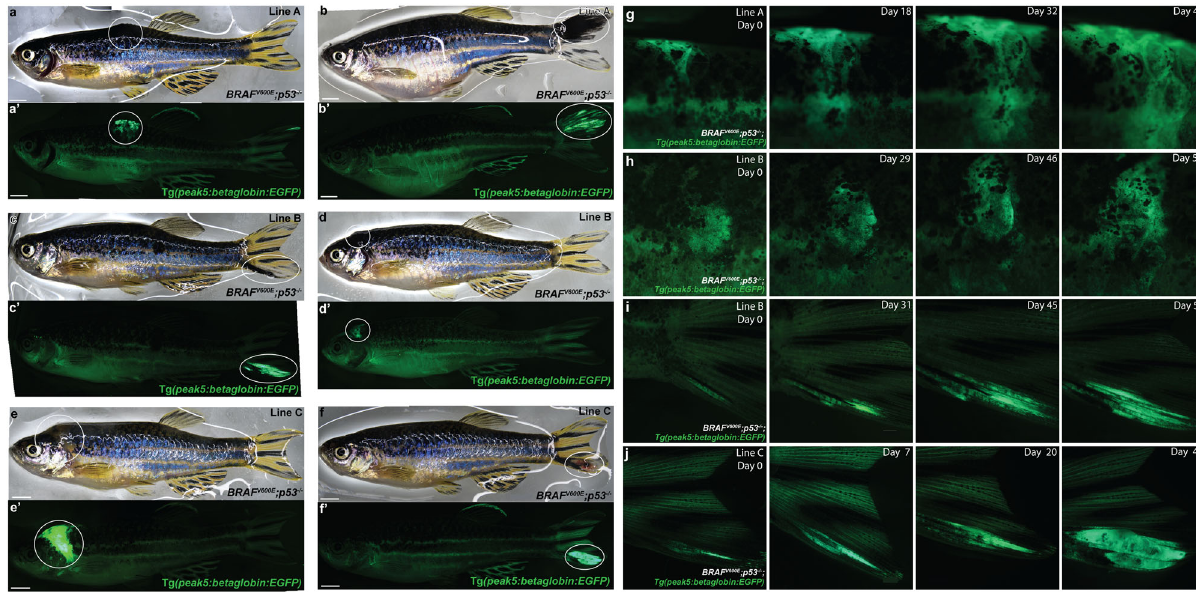
Fig. 3 peak5 is active in melanoma tumors across multiple stable lines and in melanoma precursor lesions. a , b Bright- fi eld images of tumors, circled, in Tg(peak5:betaglobin:EGFP) stable line A in the Tg(BRAF V600E );p53 − / − zebra fi sh background. a ′ , b ′ Tumors are EGFP positive and EGFP is highly expressed in tumors compared to any low EGFP expression elsewhere in the fi sh. c , d Bright- fi eld images of Tg(peak5:betaglobin:EGFP) stable line B with tumors, circled. c ′ , d ′ Tumors are EGFP positive. e , f Bright- fi eld images of Tg(peak5:betaglobin:EGFP) stable line C with tumors, circled. e ′ , f ′ Tumors are EGFP positive. g Tg (peak5:betaglobin:EGFP) stable line A zebra fi sh with dorsally located melanoma precursor lesion that grows over time. h Tg(peak5:betaglobin:EGFP) stable line B zebra fi sh with a melanoma precursor lesion in a scale that expands in size over time. i Tg(peak5:betaglobin:EGFP) stable line B zebra fi sh with precursor lesion located on the tail that grows over time. j Tg(peak5:betaglobin:EGFP) stable line C zebra fi sh with a precursor lesion on the tail that grows into a tumor. Day 0 denotes the fi rst day the precursor lesion was